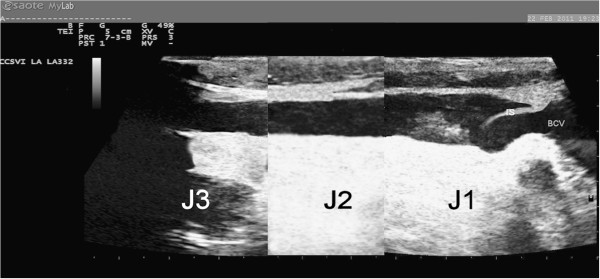
Proximal (J1) valve malformation (inverted septum). BCV = brachiocephalic vein.